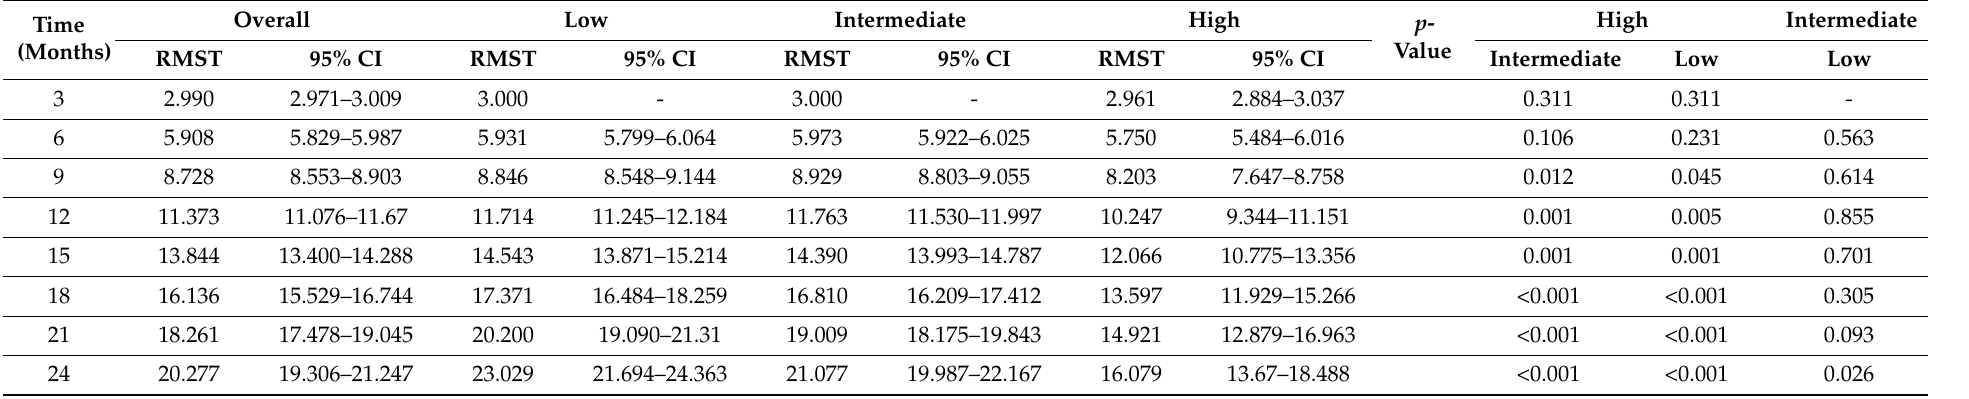
Table 5. Restricted mean survival time of the low-, intermediate-, and high-risk groups for early tumor recurrence, and their